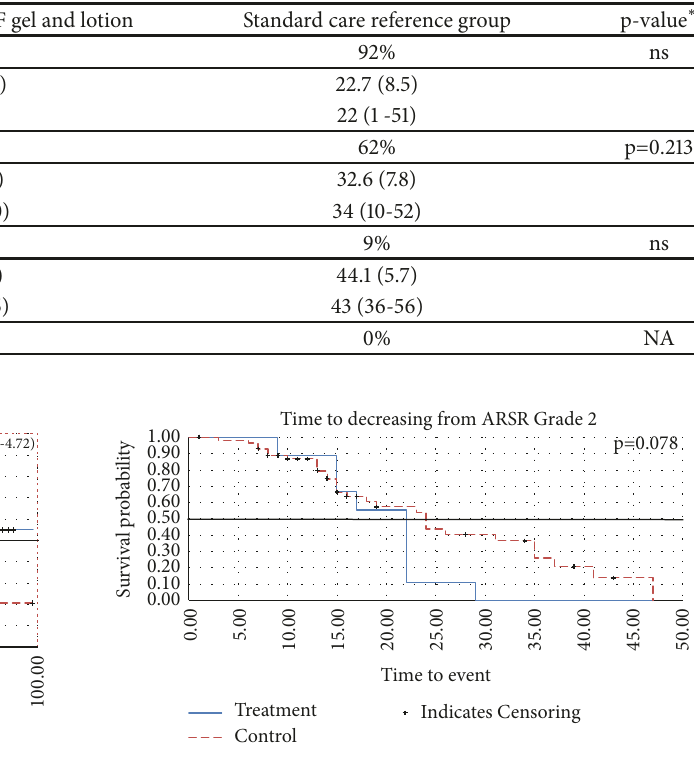
Table 2: Frequency of ARSR grades and time to ARSR Grades 1, 2, 3, and 4.